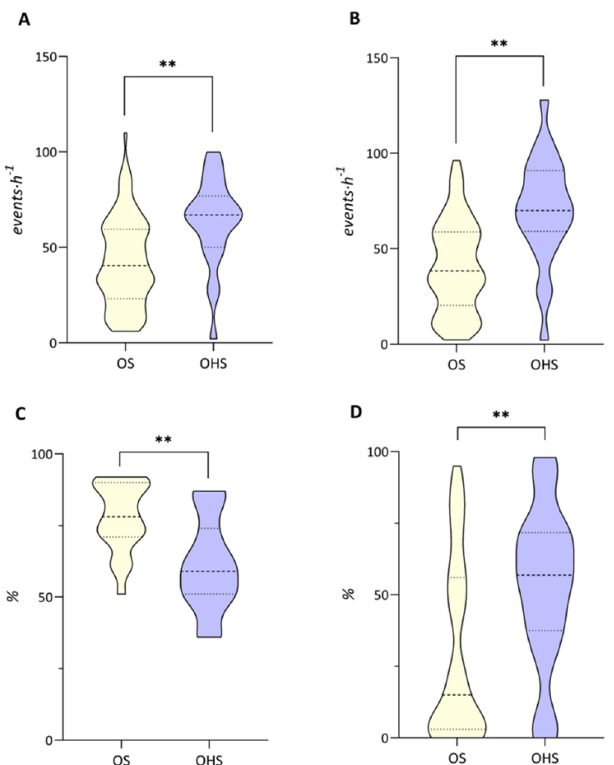
Figure 2. Comparison of sleep parameters between overlap syndrome (OS) and obesity hypoven- tilation syndrome (OHS): ( A ) apnea-hypopnea index (AHI), ( B ) oxygen desaturation index (ODI), ( C ) oxygen saturation (SaO 2 ) and ( D ) time in bed with SaO 2 <90% (T90). ** p < 0.001. Conversely, when assessing respiratory function, subjects with OS had a lower FEV 1 ( p < 0.0001) than the OHS.